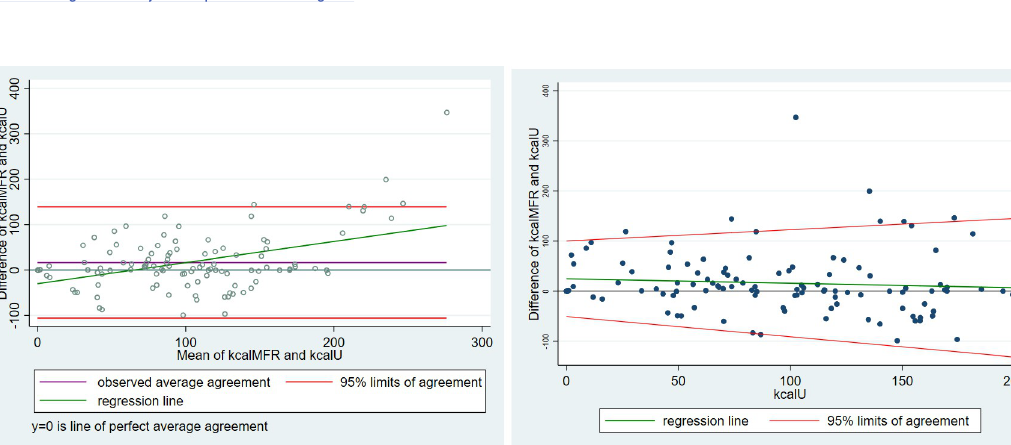
Fig 5. (Left) Classical Bland-Altman LoA plot augmented with the regression line (right) Linear regression of the differences (y1—y2) on y2 with 95% limits of agreement.